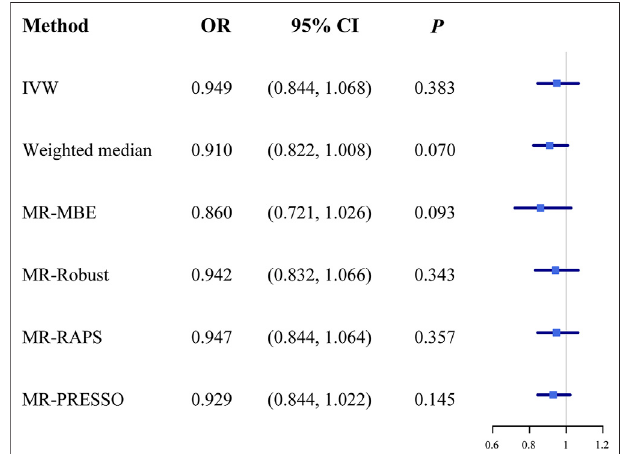
FIGURE 4 | The causal effect estimates from various MR methods. The odds ratios of tea intake on T2D are displayed as a black solid box. The 95% CIs are shown as horizontal gray lines. Abbreviations: MR, Mendelian randomization; MR-MBE, MR Mode-based estimate; MR-Robust, inverse variance-weighted method using robust regression; MR-RAPS, Robust Adjusted Pro fi le Score; MR-PRESSO, Mendelian Randomization Pleiotropy RESidual Sum and Outlier; OR, odds ratio.